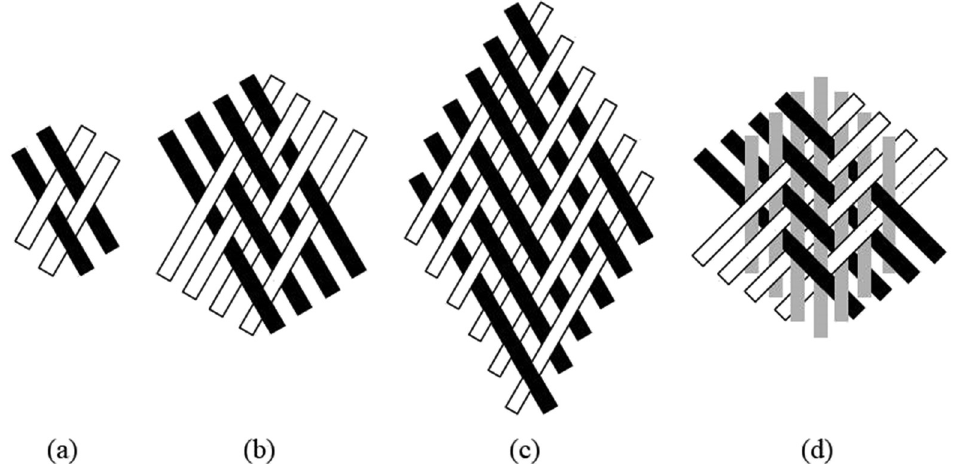
Figure 1: Braiding patterns: ( a ) diamond biaxial braid ( 1/1 repeat ) , ( b ) regular biaxial braid ( 2/2 repeat ) , ( c ) Hercules biaxial braid ( 3/3 repeat ) , and ( d ) regular triaxial braid ( 2/2 repeat )